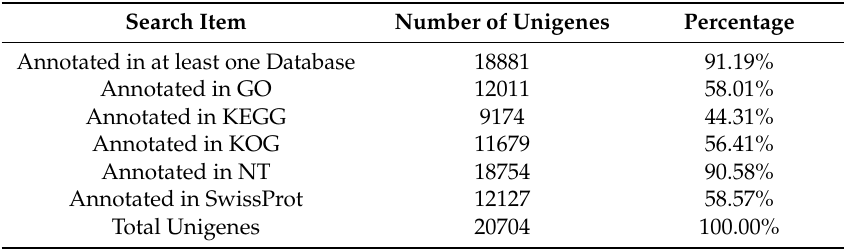
Table 3. Numbers and frequencies of unigenes annotated in public databases.